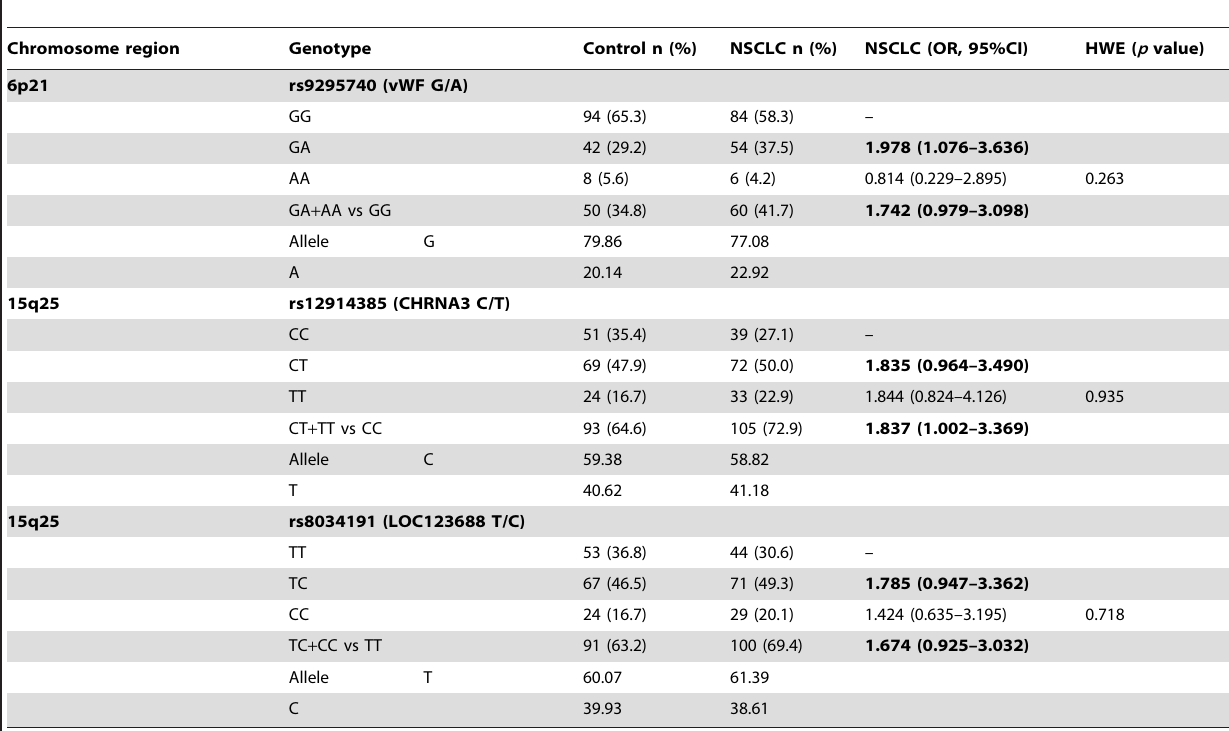
Table 3. Genotypes of the single nucleotide polymorphisms at 5p15, 6p12, 6p21, and 15q25 loci in lung cancer patients and control subjects and their association with the risk of non-small-cell lung cancer adjusted for age and gender.